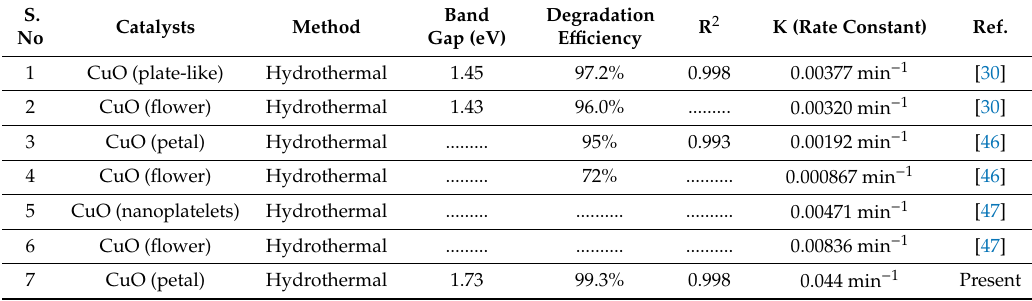
Table 1. Comparative study of catalytic properties of CuO nanostructure in the presence of H 2 O 2 for the degradation of MB dye including the present